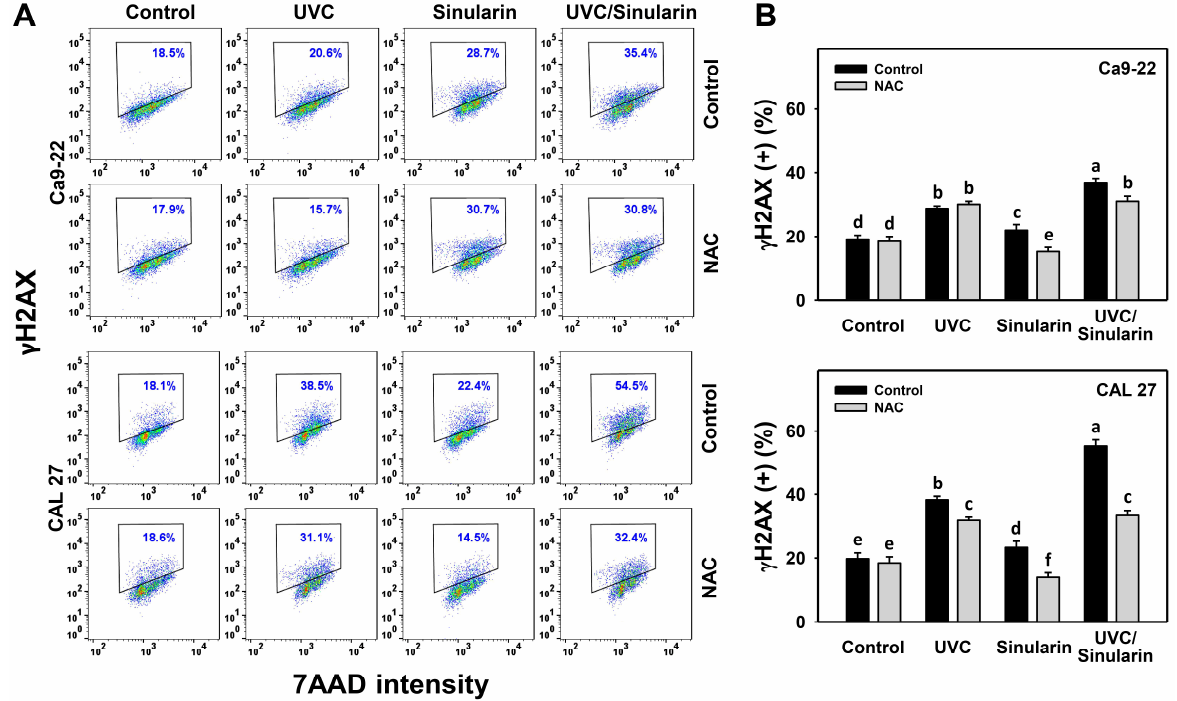
Figure 9. γ H2AX expressions of the UVC and/or sinularin treatments. Following the NAC preincubation (5 mM for 1 h) or not, the cells were arranged into four kinds of treatments: the control (0.1% DMSO in medium), UVC, sinularin, and UVC/sinularin for 48 h. The UVC and/or sinularin conditions were 12 J/m 2 , 2 µ M and 10 J/m 2 , 3 µ M for oral cancer cells (Ca9-22, CAL 27) for 48 h, respectively. ( A , B ) Patterns and quantifications for the γ H2AX analysis. The trapezoid indicates γ H2AX-positive (%). For the multi-comparisons, the treatments marked without repeated characters (a to f) differ significantly ( p < 0.05). The data were plotted as the mean ± SD ( n =